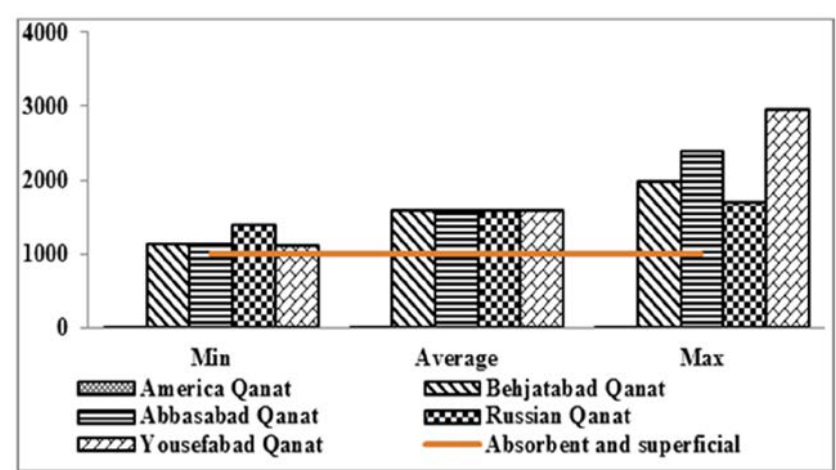
Fig. 15: Total coliforms (TC) measured of the studied aqueducts (Qanats)